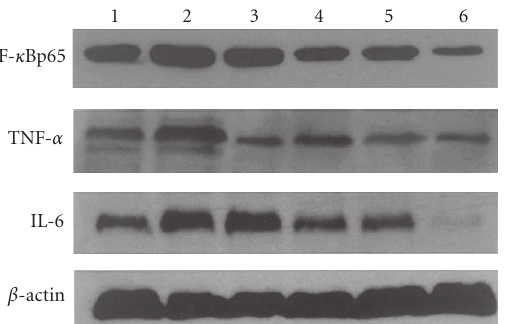
Figure 4: Western blotting showed levels of TNF- α , NF- κ Bp65 and IL-6 in colon tissue of rats. Lane 1: the N group, Lane 2: the M group, Lane 3: the 5-ASA group, Lane 4: the LD group, Lane 5: the MD group, and Lane 6: the HD